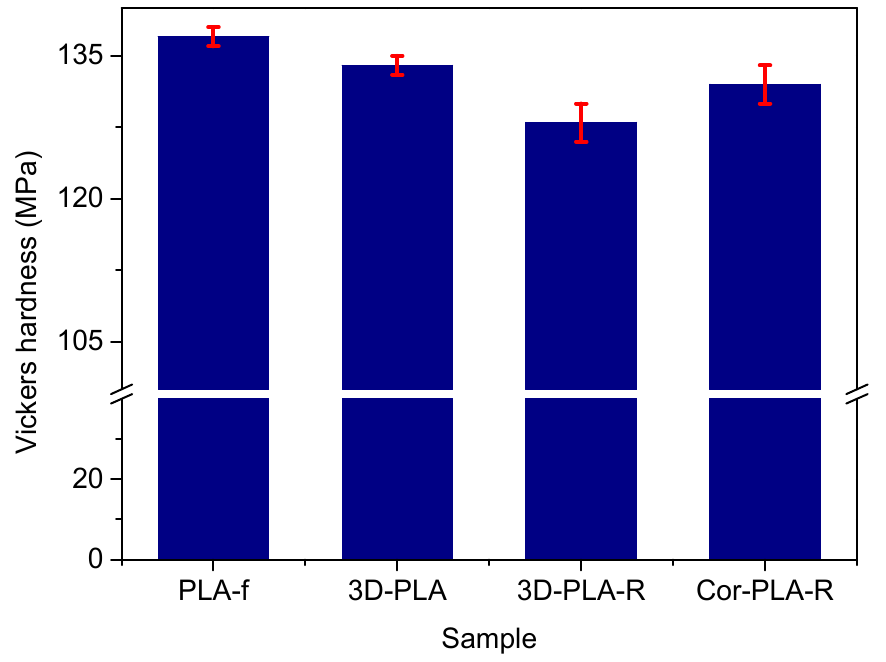
Figure 9. Vickers hardness values of the samples before and after mechanical recycling.